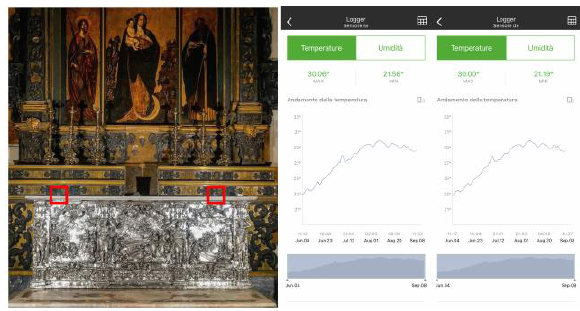
Figure 12 . Thermo-hygrometric monitoring